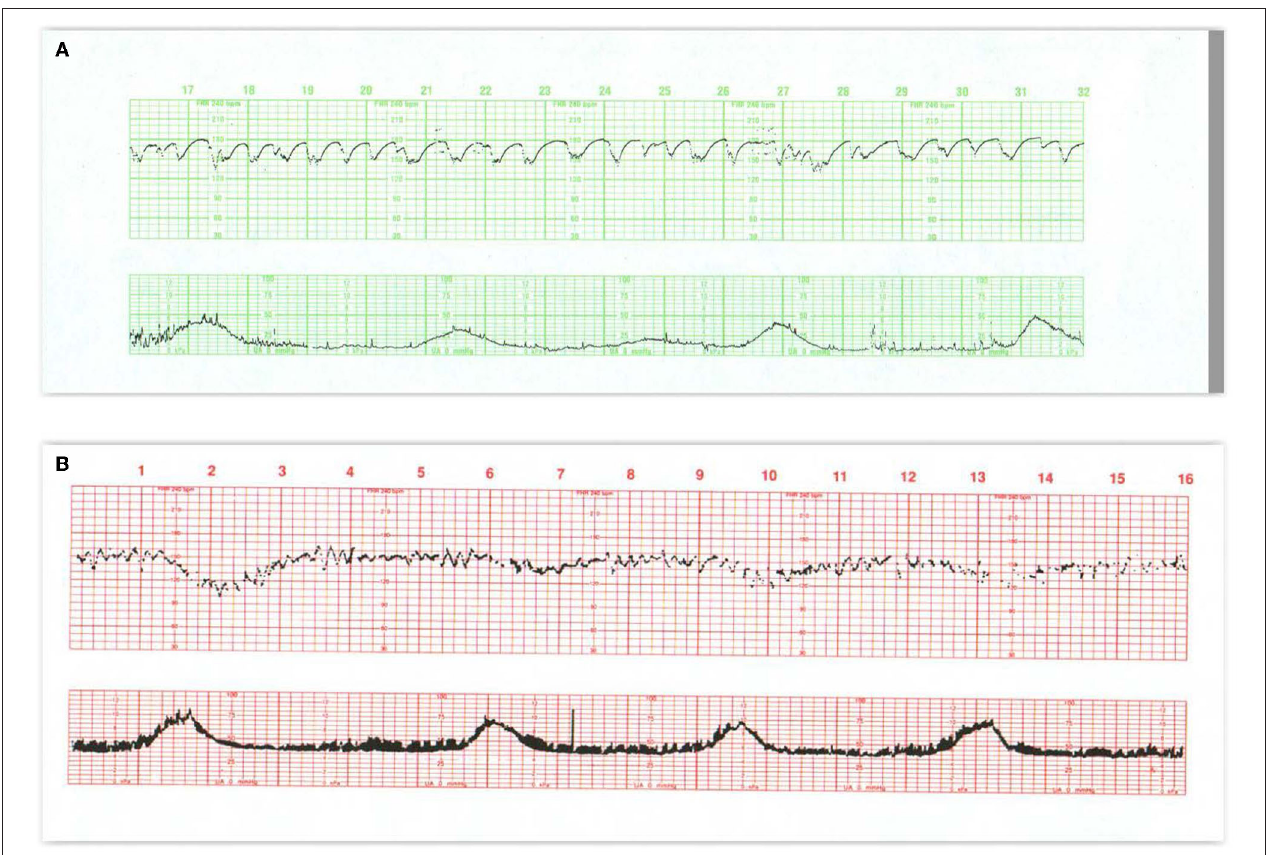
FIGURE 2 | (A) Represents an exaggerated “scallop” pattern, probably associated with fetal sucking and decreased fetal movement. This is a benign behavioral pattern. (B) Tracing invites classification as a positive admission test. The panel contains unequivocal decelerations that appear late in timing, but there is significant variation in the onset and duration of the decelerations. The baseline variability is moderate and shows no tendency to tachycardia or decreased variability. The UC channel reveals high frequency, low amplitude, somewhat irregular spikes which represent fetal breathing movements. When fetal breathing movements cease, the decelerations disappear. A benign tracing. Scaling − 30 bpm/cm—vertical, 3 cm/min—horizontal—each panel is 16min